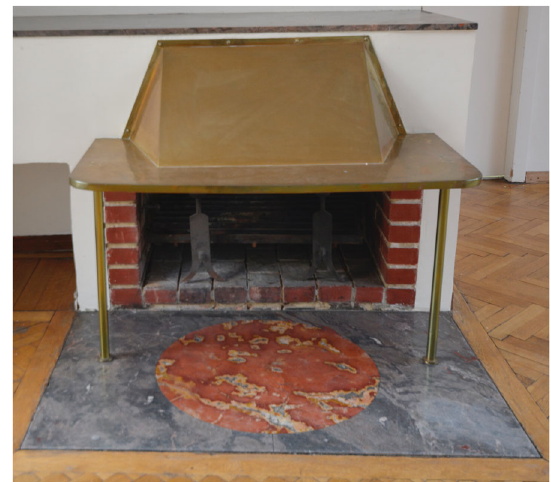
Fig. 25 Josef Frank and Oskar Wlach, Villa Beer in Vienna-Hietzing (1930), living room, fireplace with polished slabs of reddish limestone ( ‘ onyx ’ marble), crinoid limestone and brass chimney